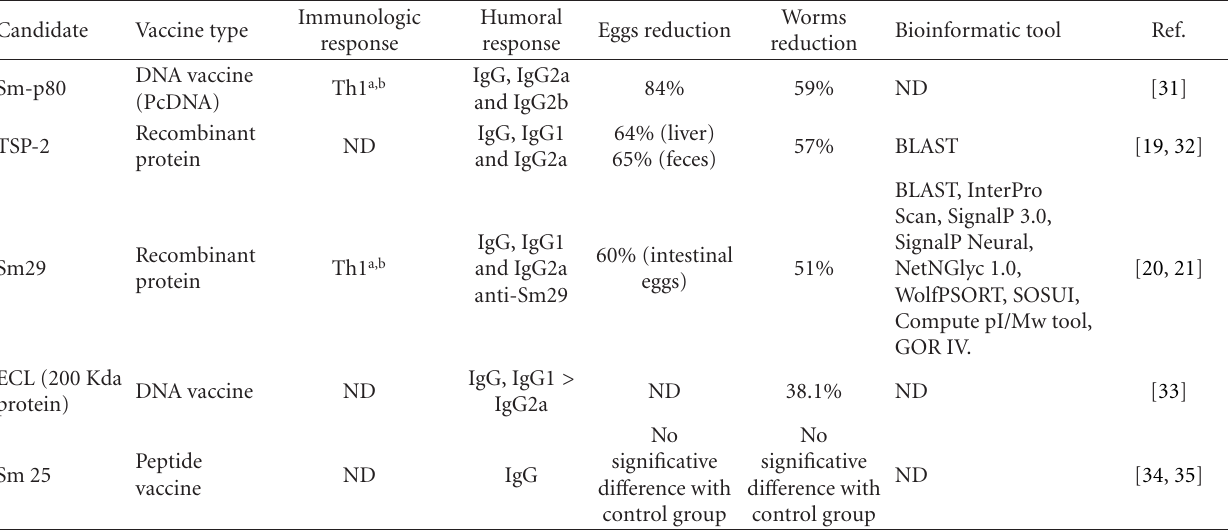
Figure 1: Most common methodology for investigation of potential vaccine candidates. Possible targets are predicted based on sequences databases and proteomic analysis. Further bioinformatic studies provide detailed information about protein primary structure, topology, subcellular localization, conserved domains, HLA-peptide binding, and posttranslational modifications. ∗ [7–10]. Table 1: S. mansoni tegument surface exposed proteins evaluated as vaccine